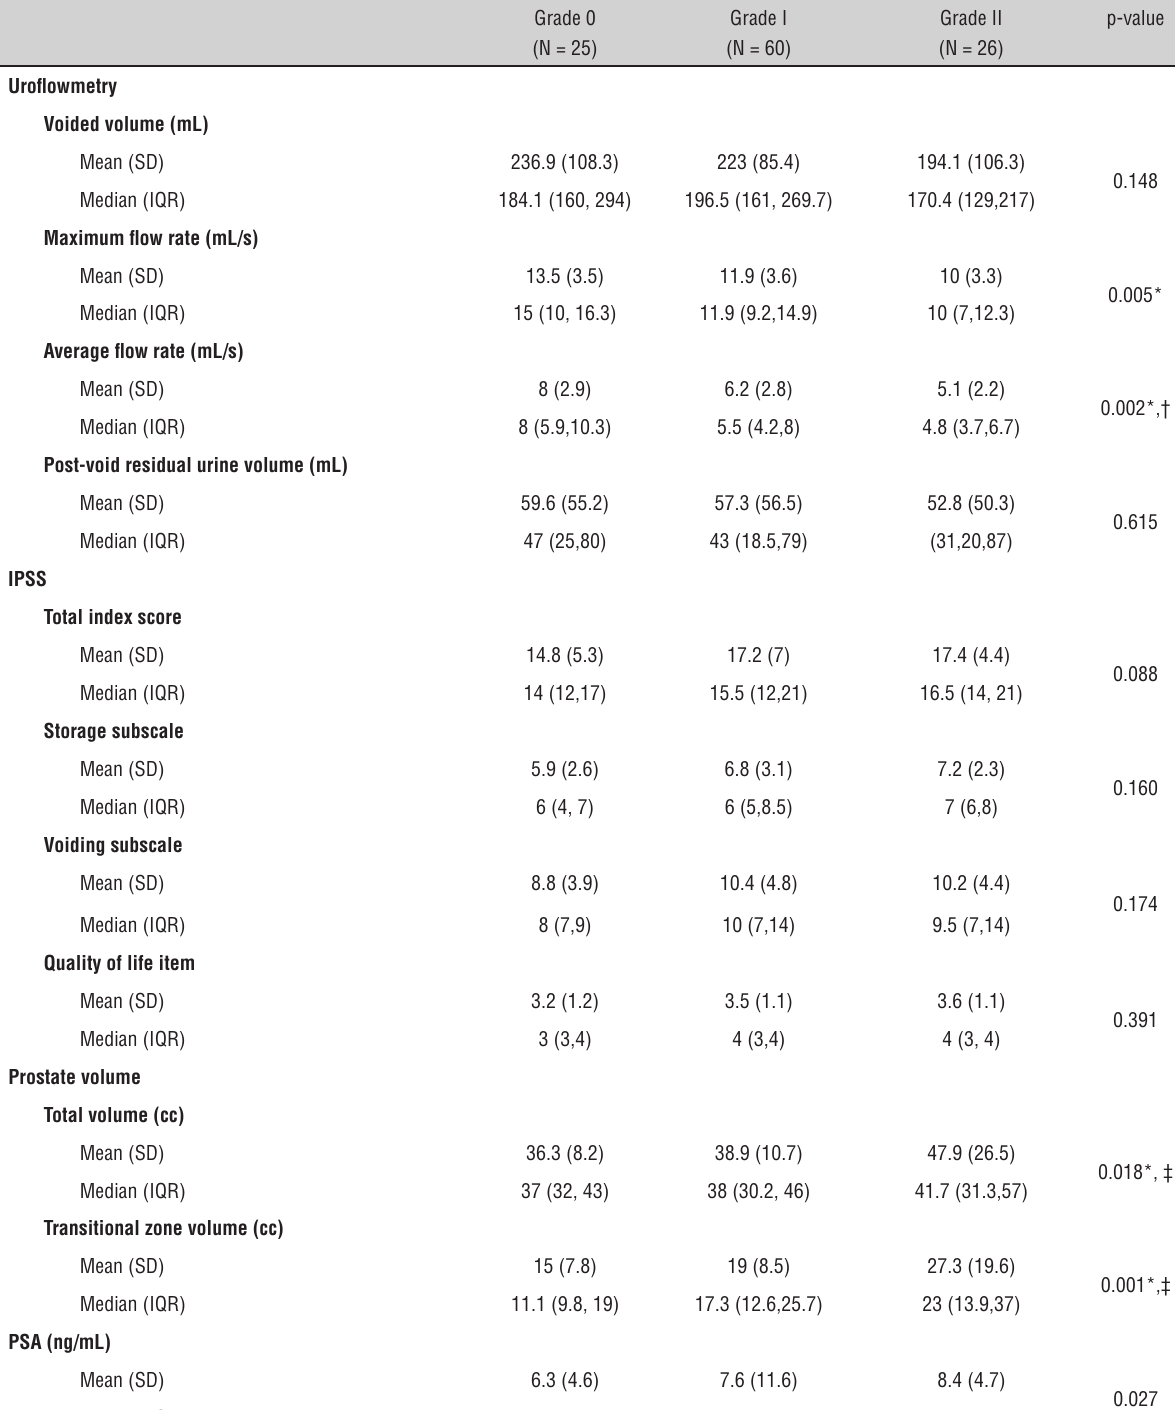
Table 2 - Differences in baseline LUTS parameters according to inflammation